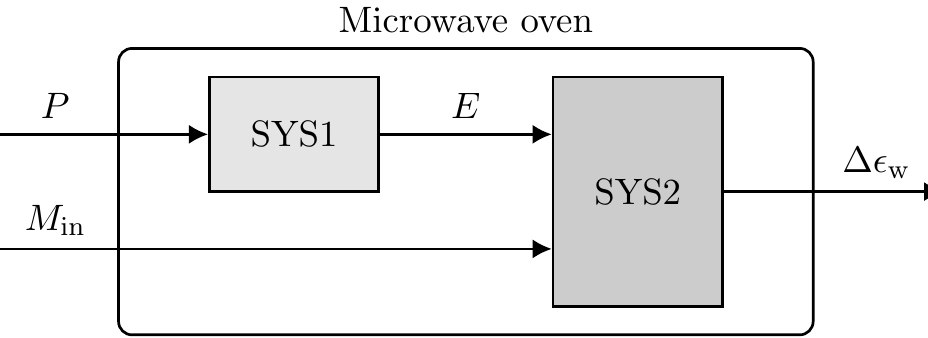
Figure 7. Dividing the microwave oven system into two